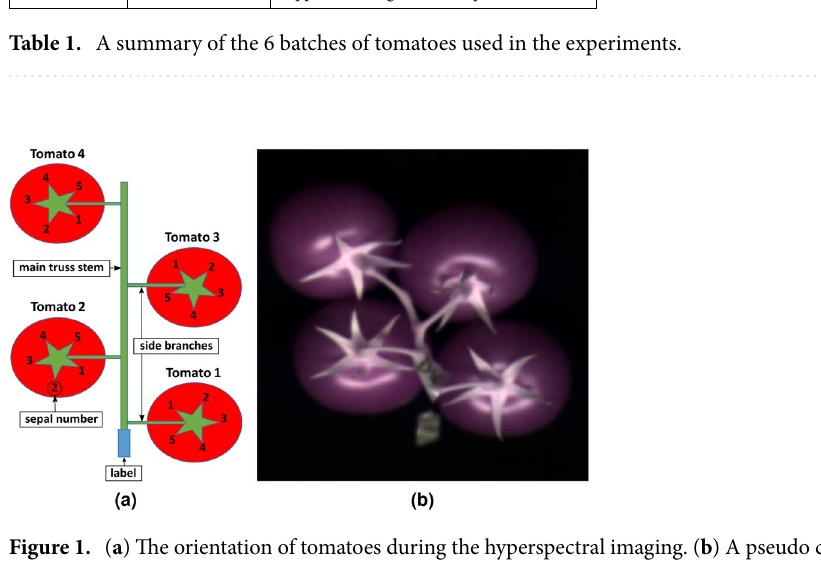
Figure 1. ( a ) The orientation of tomatoes during the hyperspectral imaging. ( b ) A pseudo color image of one truss obtained by combining three spectral